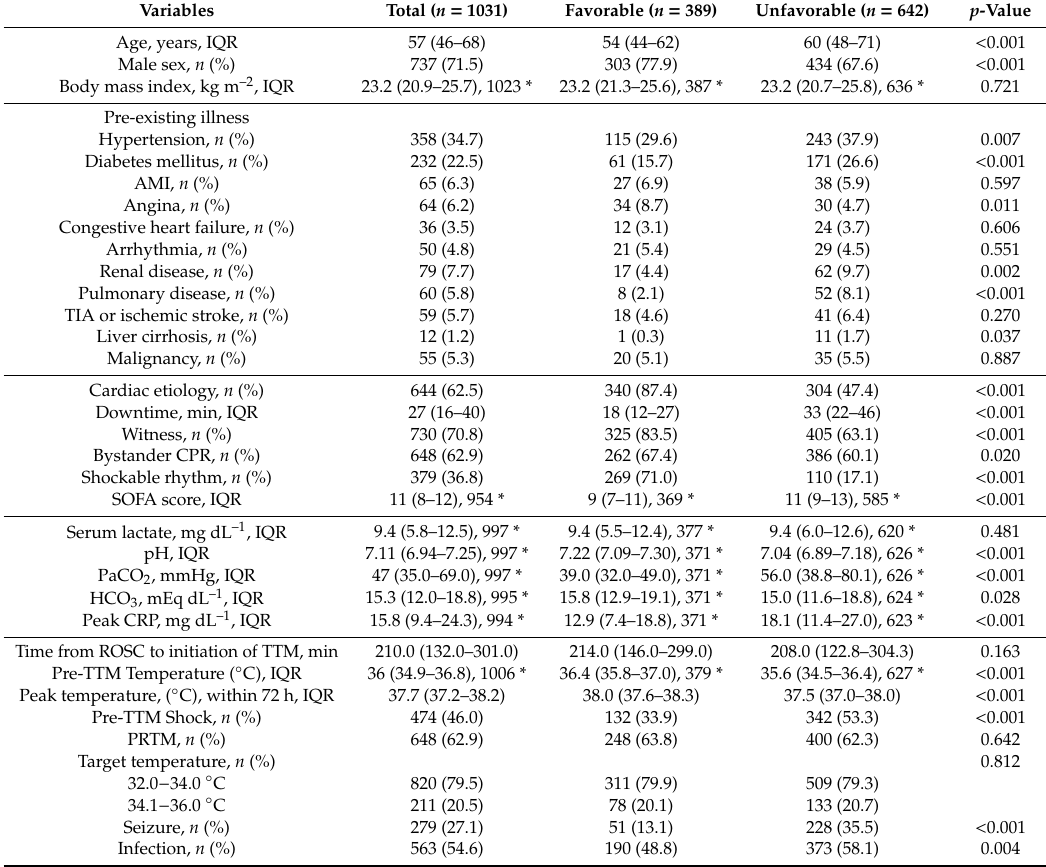
Table 1. Demographics and characteristics of the included patients according to neurologic outcomes at 6 months after hospital